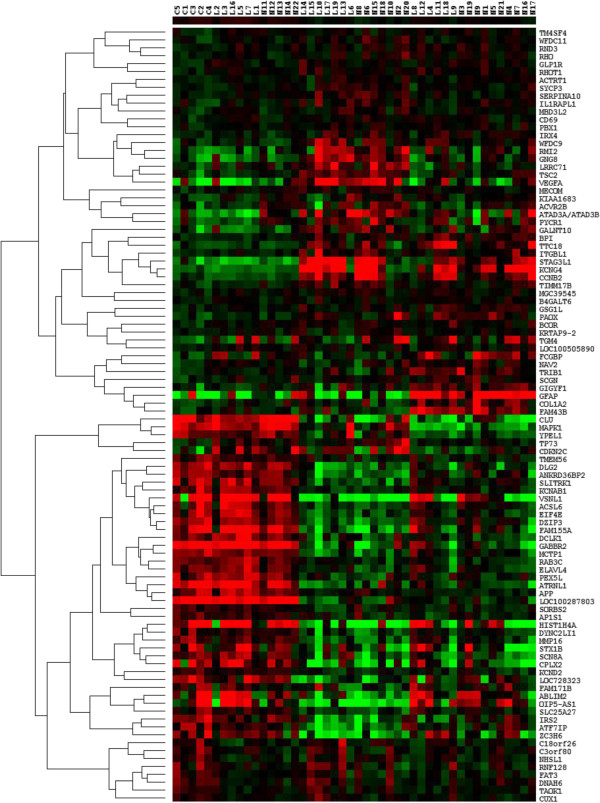
Differentially expressed mTOR-related genes in either mild or advanced AD. Heat map visualising the expression level of the 98 genes that were either differentially expressed in mild AD (17 genes) or in advanced AD (81 genes) only. The cut-off point for differential expression was <10% FDR. The heat map was generated with Cluster and Treeview, with complete hierarchical clustering by gene and array. The expression level of each gene relative to the median expression of the gene across all samples is represented on a red-green colour scale. The colours represent the log ratio of gene expression in an individual patient. Downregulated genes are represented in green (saturated green: log ratios −3.0 and below) while upregulated genes are represented in red (saturated red: log ratios 3.0 and above). Cells with log ratios of 0 (gene expression unchanged) are black. The arrays are identified by the patient codes that are described in Additional file 2: Table S1 (C: Control, L: Limbic stage AD, N: Neocortical stage AD) while the genes are identified by the gene name.